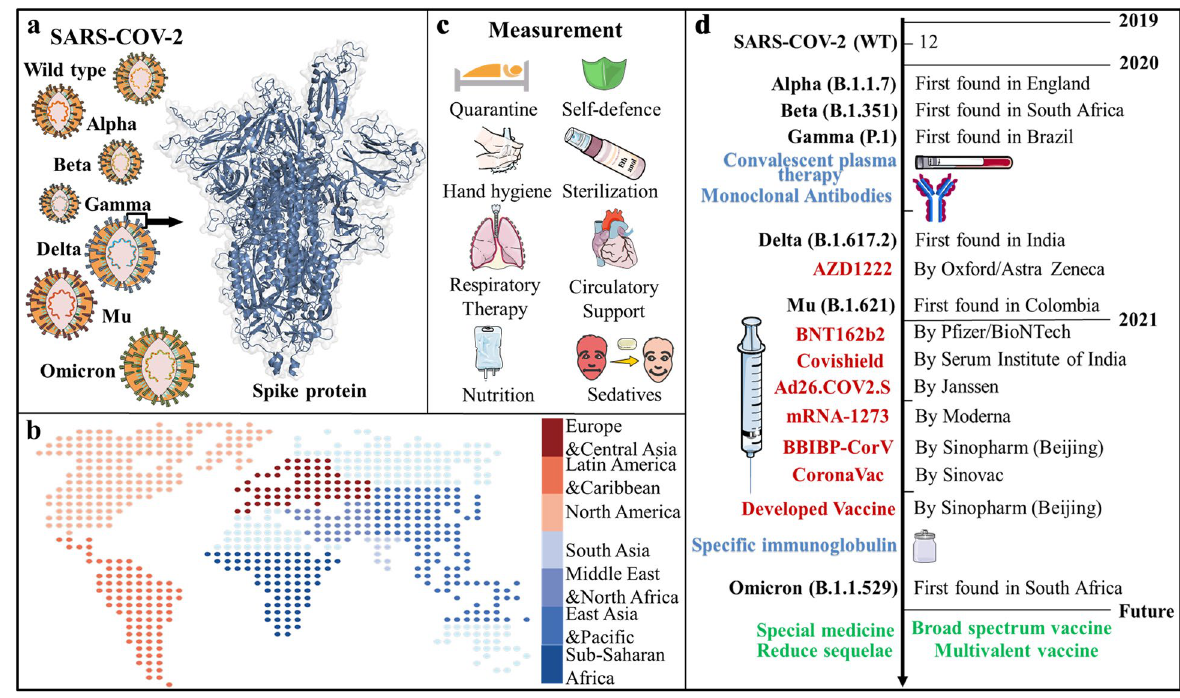
Fig. 1 Distribution and treatment strategies of COVID-19. a Schematic overview of the SARS-CoV-2 spike protein trimer; b cumulative distribution of confirmed COVID-19 cases worldwide by region (The darker the red, the more people are infected with COVID-19, the darker the blue, the less people are infected); c measures to deal with COVID-19; d a time line of SARS-CoV-2 variants with treatments in blue, vaccines under Emergency Use Authorization (EUA) in red and expectations in